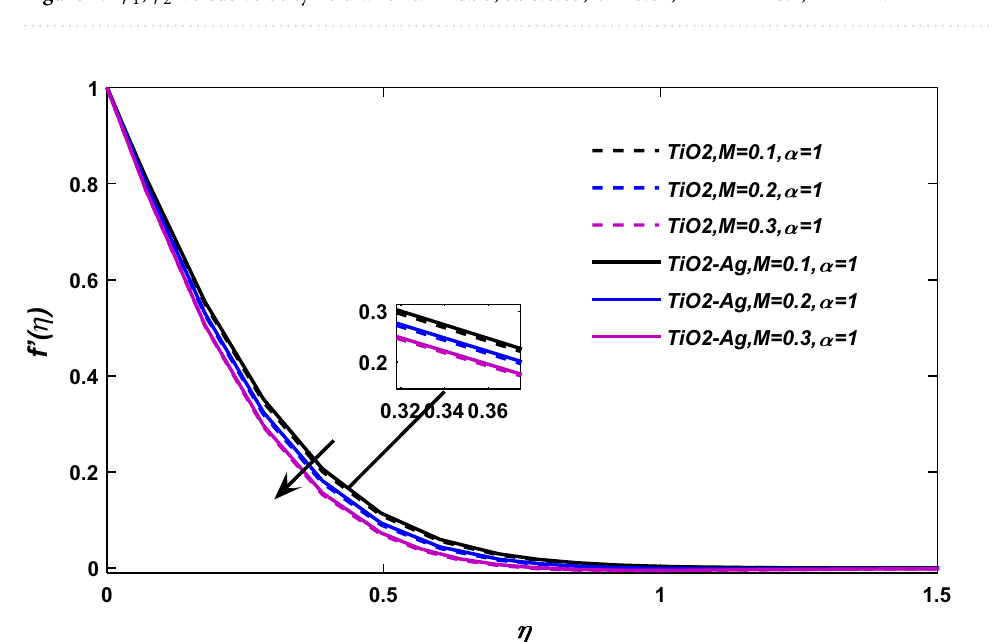
Figure 5. M versus velocity field when E = 0.1, (cid:31) = 0.01, φ 1 , φ 2 = 0.02, α = 1, Pr =